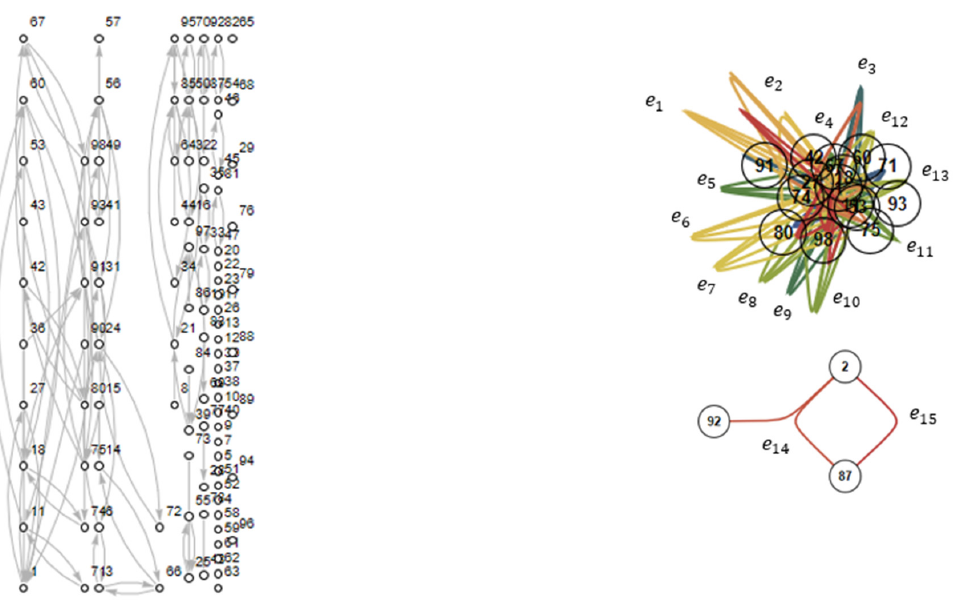
Figure 7. Directed network (on the left) and a network soft set (on the right) representation for the post-COVID-19 economic period. Note: Numbers denote company indices (see Tables A1 and A2) and E = { e 1 , e 2 , . . . , e 15 } is the soft parameter